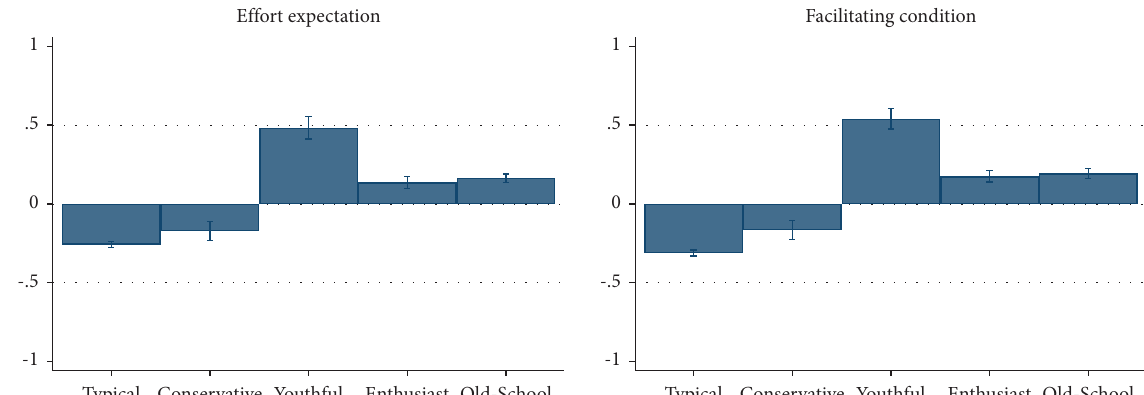
Figure 3: Learning latent constructs: efort expectancy and facilitating conditions. Latent factor scores on vertical axis. Four items used for generating the EE-latent construct: learning how to use a CAC would be easy for me; it is expected that a CAC would be easy to use; it would be easy to become skillful at using a CAC; a CAC is recommended to others. Four items used for generating the FC-latent constructs: acquiring the necessary knowledge to use a CAC; it is expected the use of a CAC to be compatible with other digital devices that is used; it is expected to have the necessary knowledge to use a CAC; it is expected to get help from others while having difculties using a